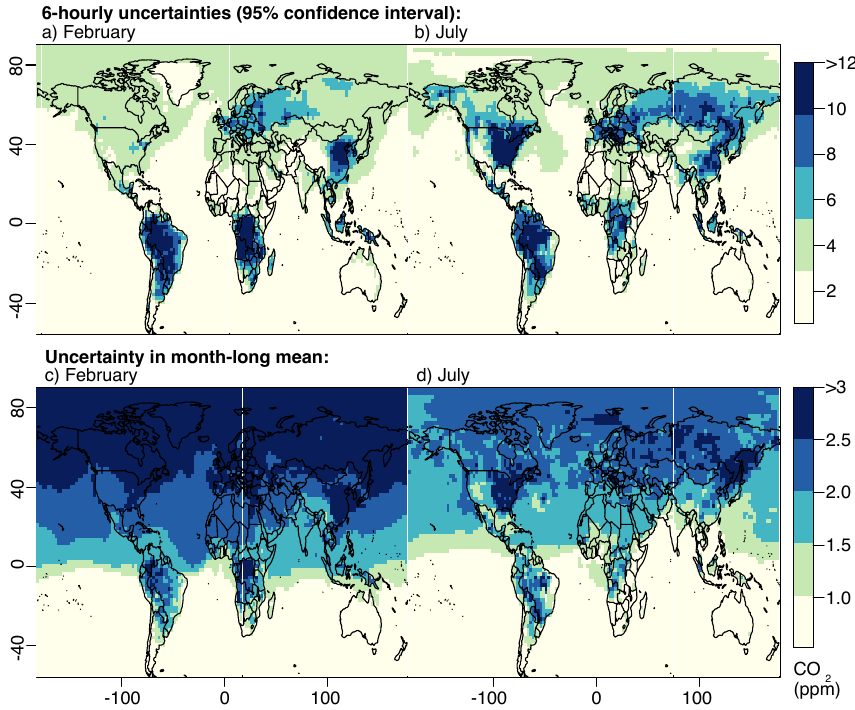
Figure 2. The top panels display average 6-hourly CO 2 transport uncertainties estimated by CAM-LETKF. The uncertainties (95% confi- dence intervals) are for the surface model layer for (a) February and (b) July 2009. The bottom panels ( c and d ), in contrast, display the uncertainties in month-long averaged surface CO 2 concentrations. Note that these plots include model output from all 24h of each day. The Supplement provides analogous figures for daytime- or nighttime-only model